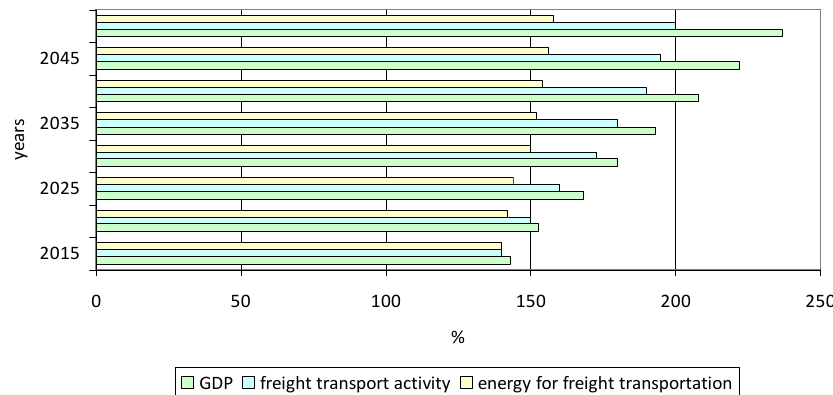
Fig. 1: Trends in transport activity and energy consumption. (European Commission, 2016)